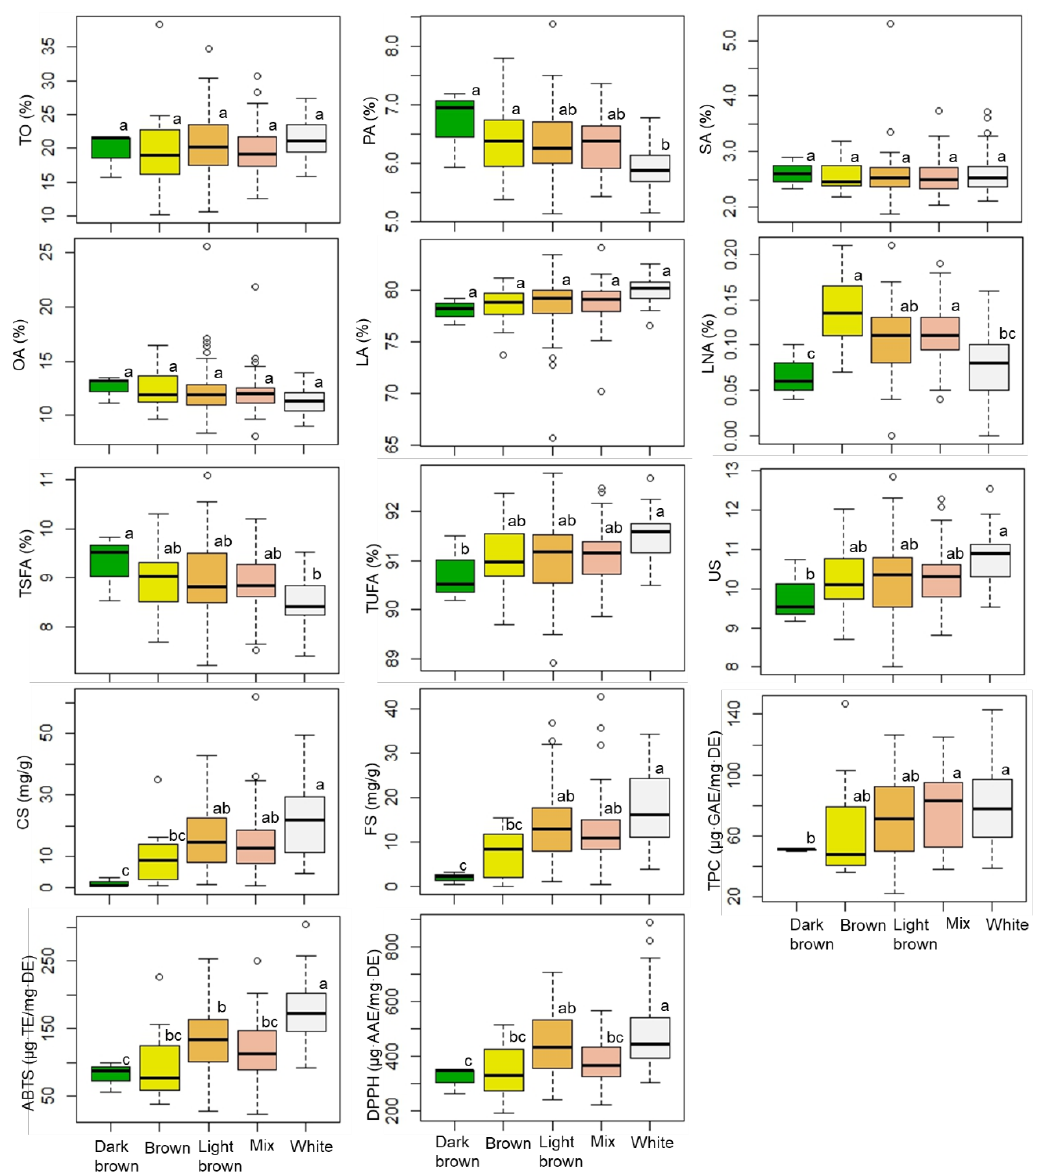
Figure 1. Variations in total oil content, fatty acid profile, phytochemical contents, and antioxidant activities of safflower seeds according to seed coat color. TO, total oil; PA, palmitic acid; SA, stearic acid; OA, oleic acid; LA, linoleic acid; LNA, linolenic acid; TSFA, total saturated fatty acid; TUFA, total unsaturated fatty acid; US, the ratio of TUFA to TSFA; CS, N -( p -coumaroyl) serotonin; FS, N -feruloylserotonin; TPC, total phenolic content; ABTS, ABTS radical scavenging activity; DPPH, DPPH radical scavenging activity. Values in the same row marked with different superscript letters are significantly different ( p <